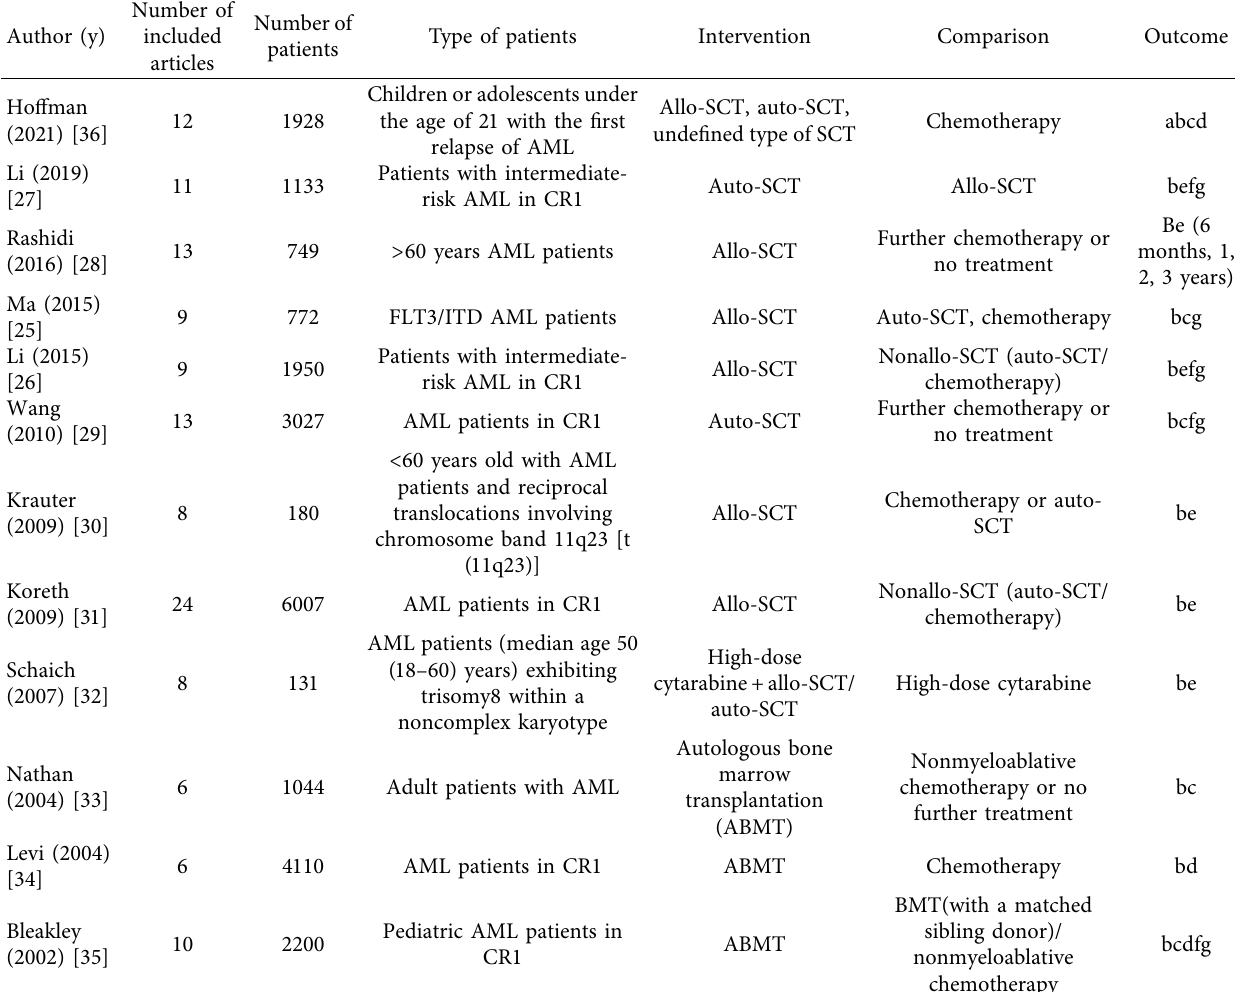
Table 1: Characteristics of included